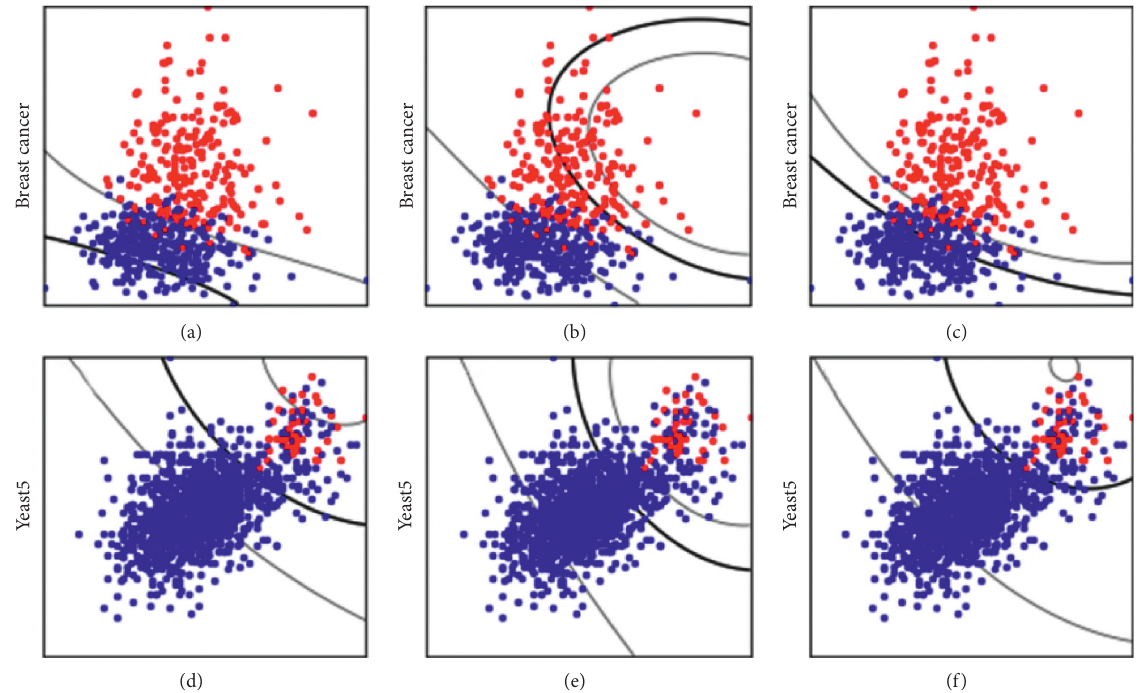
Figure 3: Comparative observation of the decision boundaries with various k values. The decision boundaries are represented by the black lines and the margins by the gray lines. (a) k � 1. (b) k � 3. (c) k � 2.416. (d) k � 1. (e) k � 3. (f) k � 2.